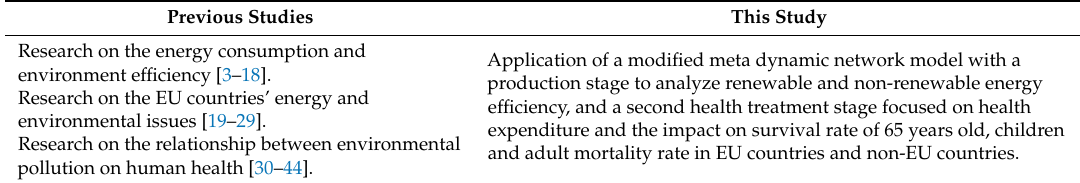
Table 1. Comparison of previous studies and this